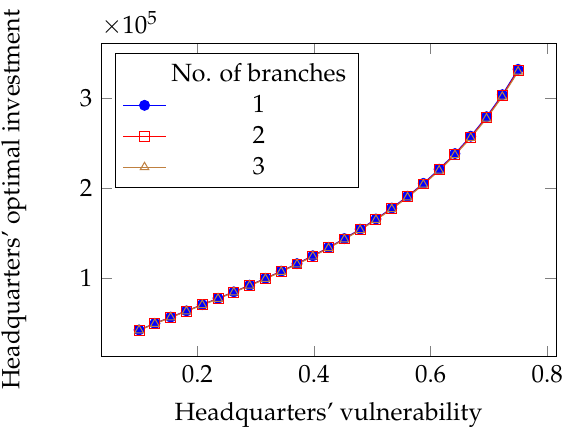
Figure 15. Optimal investment for the headquarters in the limited liability with deductibles case.